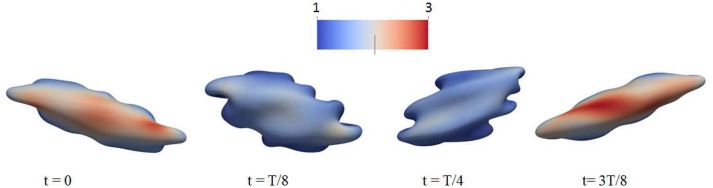
Deformation of a red blood cell in a strong high-frequency oscillatory shear flow field. The amplitude of the shear flow is 2,000 s−1 and the frequency is 100 Hz. The cytosolic/medium viscosity ratio was equal to 1; the average shear stress applied to the cell was in the range τ¯~12Pa. The color contour shows the shear deformation χ of the skeleton. Areas in red color are judged to be those with a high probability for vesiculation (see section 4.4). χ = 1 (blue) to 3 (red).